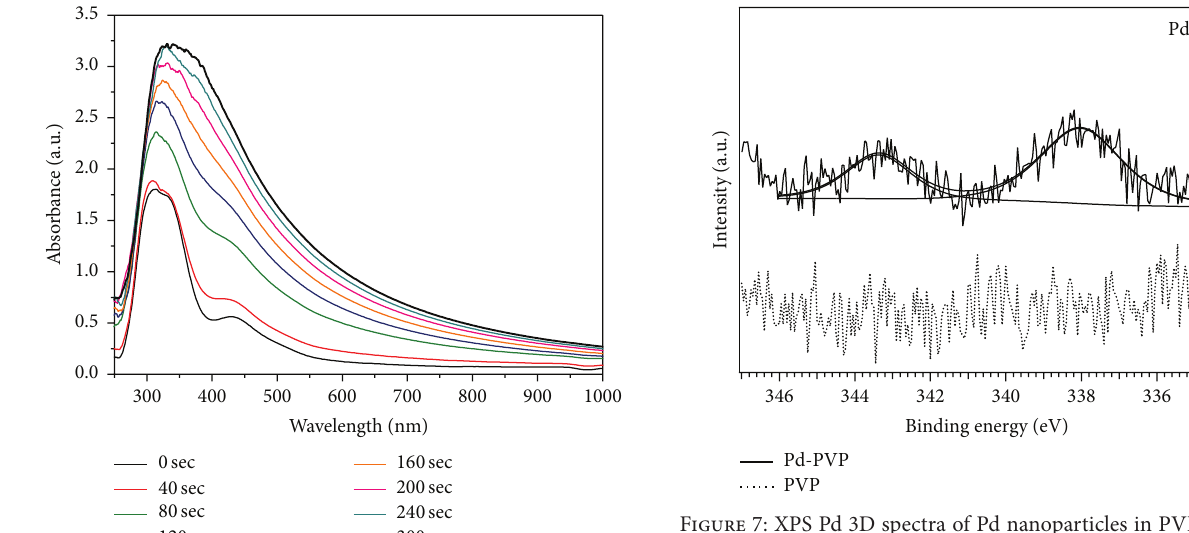
Figure 7: XPS Pd 3D spectra of Pd nanoparticles in PVP and of a pure PVP sample for